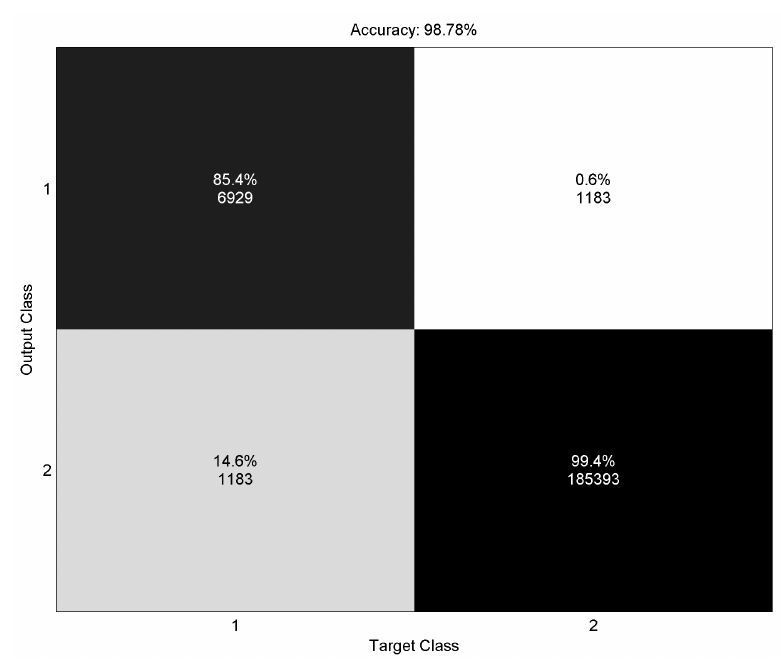
Figure 8. Confusion matrix of gesture classification (1-vs-all).